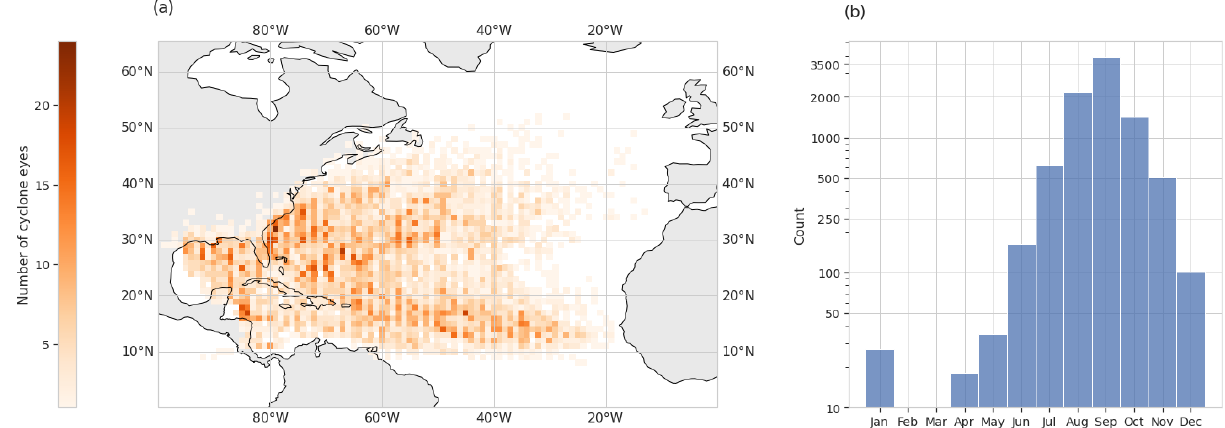
Figure 1. (a) Counts of TC-containing images per 1 ◦ × 1 ◦ grid box. (b) Histogram of the count of TC-containing images according to the month of the year. Panels (a) and (b) are computed over the period 1980–2019.